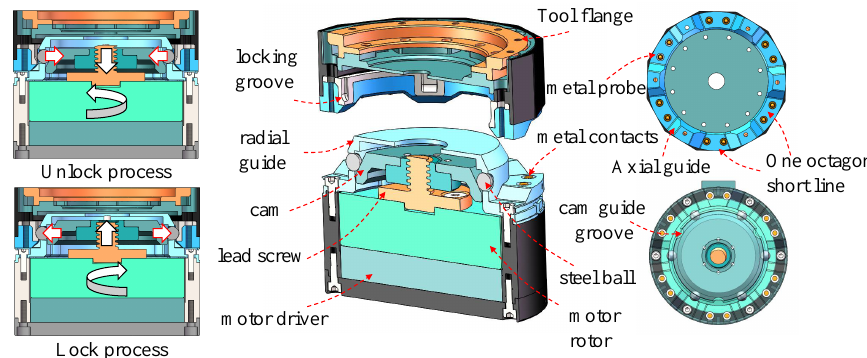
Figure 4. The hardware design of the tool interface